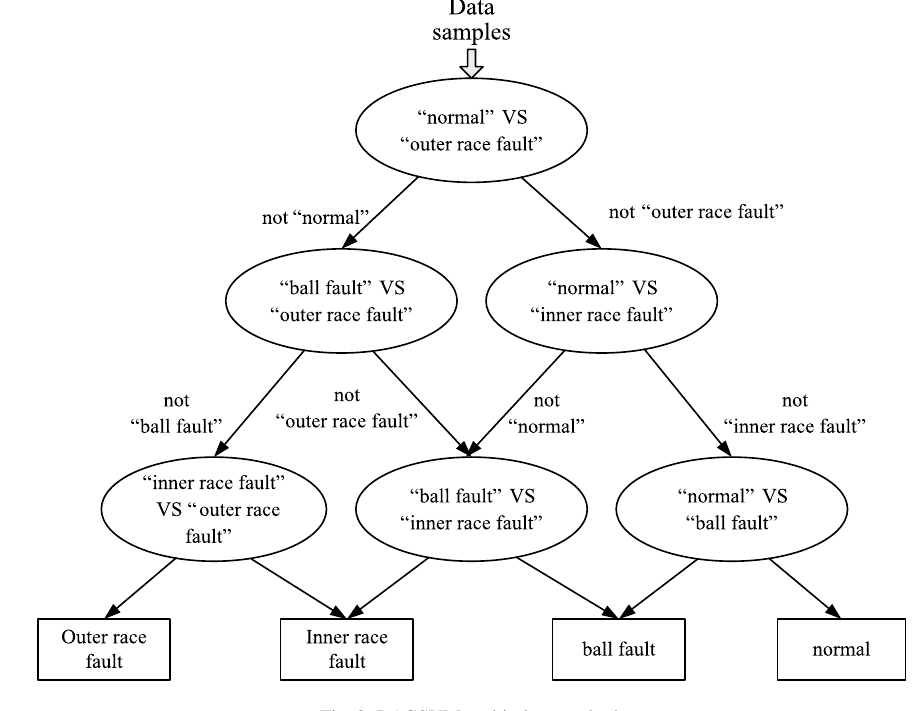
Fig. 2. DAGSVM multi-class